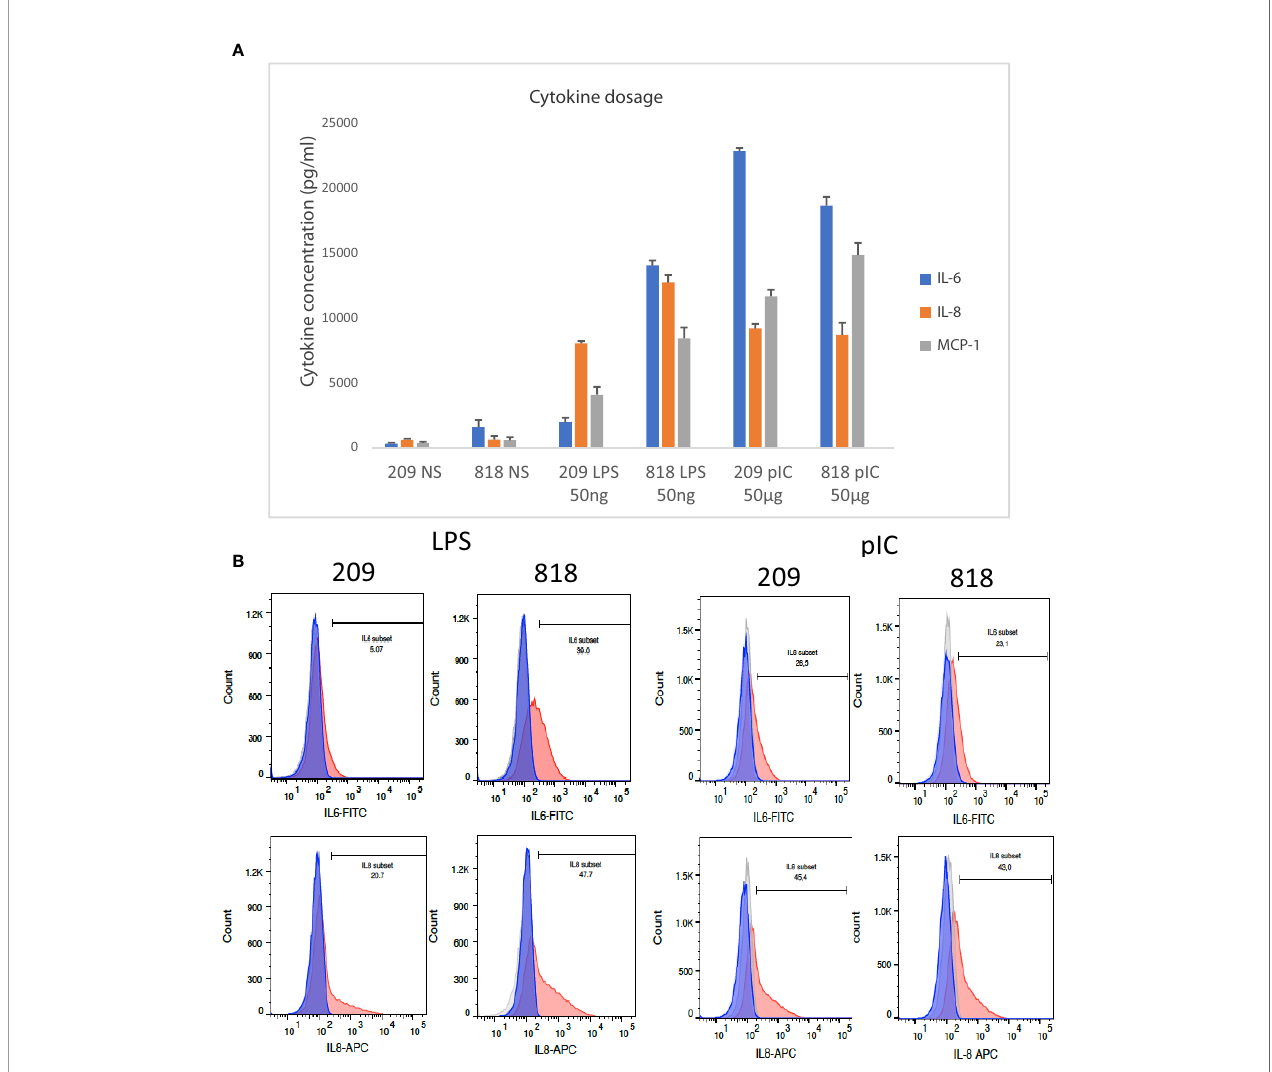
FIGURE 4 | Analysis of cytokine expression by FACS and Luminex dosage. (A) IL-6, IL-8, and CCL2 cytokine dosage in the supernatant of 209 and 818 stimulated by lipopolysaccharide (LPS) and poly (I:C) and non-stimulated controls. Bars plot the mean ± sd of triplicates of each experimental point. Concentrations are given in pg/ml. (B) Flow cytometry analysis of IL-6 and IL-8 expressed by fi broblasts after LPS or poly (I:C) stimulation and control non-stimulated cells: the light grey histogram corresponds to non-labeled non-stimulated cells, the dark grey to stimulated non-labeled cells, the blue histogram represents non stimulated labeled cells and the red histogram cells stimulated and labeled. The bar indicates the percentage of labeled cells in stimulated conditions compared to controls. On the left: comparison of 209 and 818 cells stimulated by LPS; on the right: comparison of 209 and 818 cells stimulated by poly